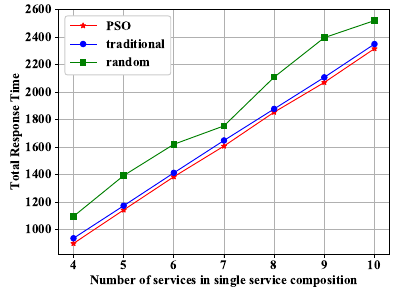
Figure 4. The total waiting time with a different number of resources.